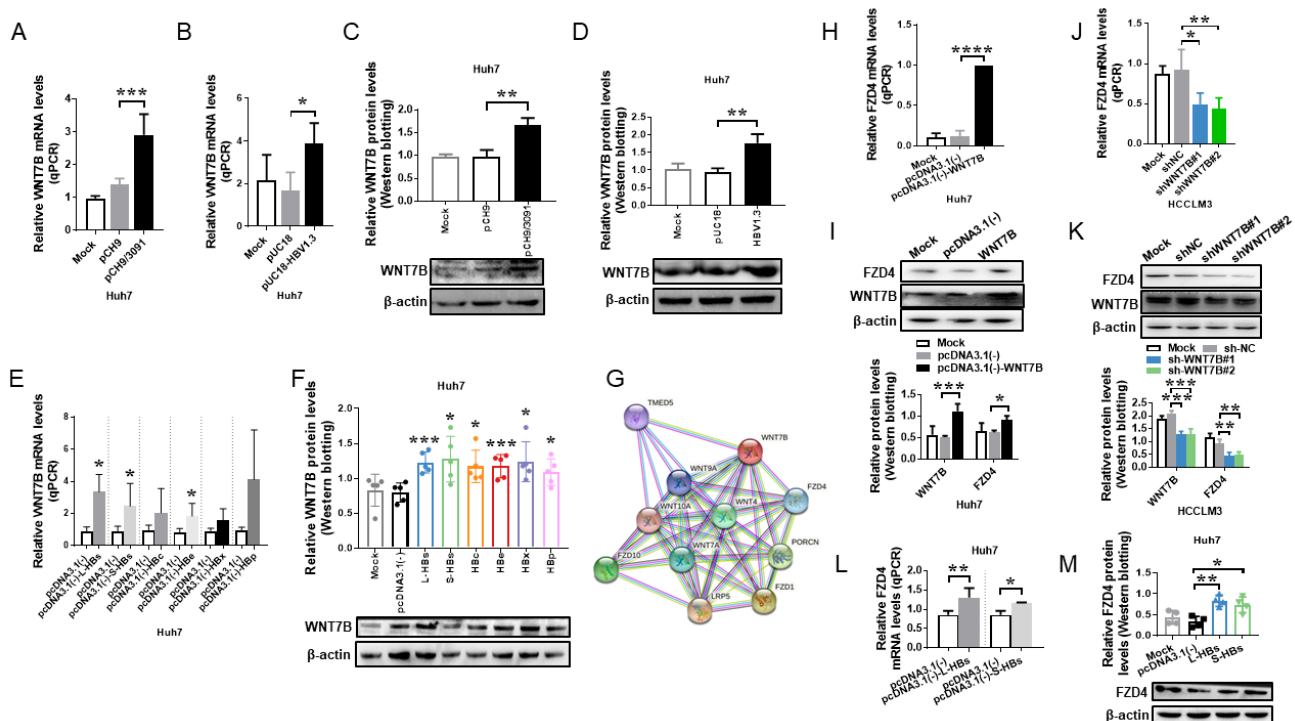
Figure 2. WNT7B and its receptor FZD4 are activated by large hepatitis B surface antigens (L-HBs). ( A , B ) qPCR analysis of WNT7B mRNA levels following pCH9/3091 or pUC18-HBV1.3 transfection. ( C , D ) The WNT7B protein level was investigated using a Western blotting test in response to pCH9/3091 or pUC18-HBV1.3 transfection. ( E , F ) WNT7B expression was measured using qPCR ( E ) and Western blotting ( F ) after the transient transfection of six HBV structural proteins (L-HBs, S-HBs, HBc, HBe, HBx, HBp). ( G ) The STRING bioinformatics tool was used to predict WNT7B interacting proteins. ( H , I ) FZD4 expression was measured by qPCR ( H ) and Western blotting ( I ) following WNT7B overexpression. ( J , K ) FZD4 expression was determined by qPCR ( J ) and Western blotting (K) following WNT7B knockdown. ( L , M ) The FZD4 expression level was determined